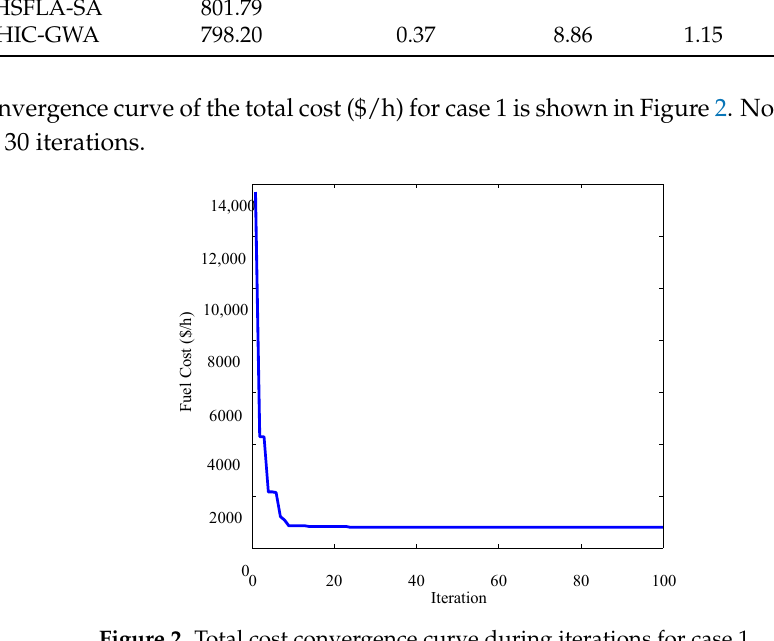
Figure 2. Total cost convergence curve during iterations for case 1.